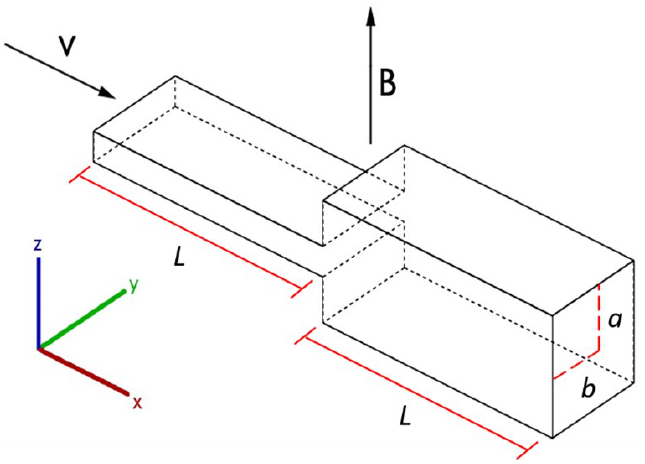
Figure 7. Geometry sketch of the experimental section.